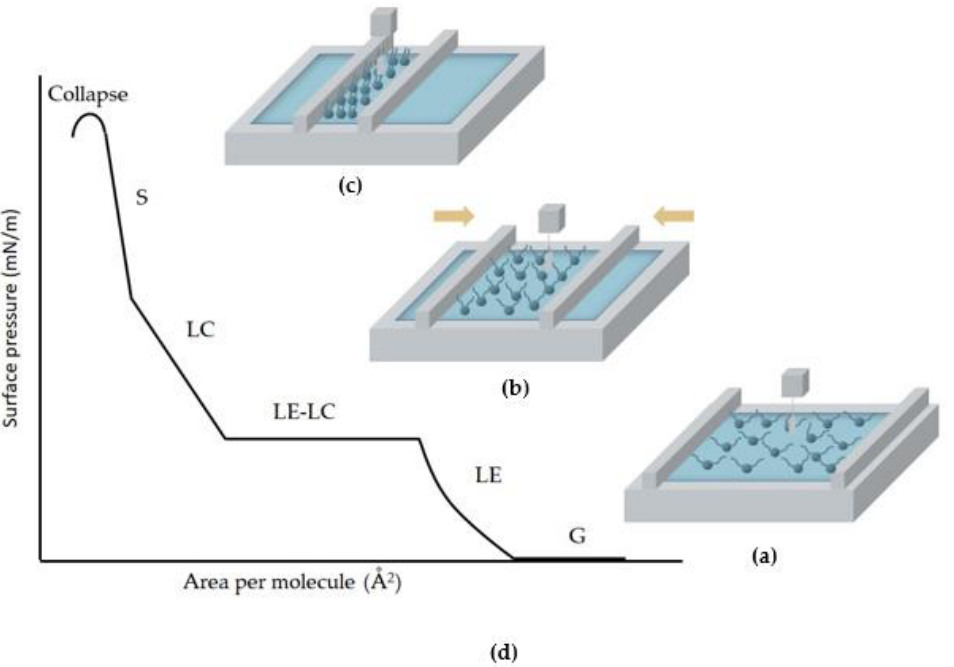
Figure 2. A schematic representation of the Langmuir monolayer formation process. ( a ) The lipid molecules are dissolved in an organic solvent and dispersed on the aqueous surface. The hydrophobic tails remain in the air with large tilt angles facing away from normal to the interface. ( b ) The two mobile barriers start to compress at a constant rate, and the Wilhelmy plate monitors the pressure. ( c ) Finally, the monolayer is formed with the molecules being perfectly organized. ( d ) A schematic of the π -A isotherm of the phospholipids. G: gaseous phase; LE: liquid expanded; LC: liquid condensed; and S: solid. During the compression process, the monolayer undergoes several phase transitions, from gaseous, to liquid, to solid states, and finally is perfectly self-oriented at the interface. Different phases are attributed to different degrees of freedom at various molecular organizations. Initially, the monolayer is in the gaseous phase with few interactions between the molecules. As the monolayer is compressed, the transition from the gaseous to liquid-expanded state occurs. The monolayer starts to be coherent, but the tail groups of the phospholipids are randomly oriented. As the area per molecule is further reduced, there are condensed lipid domains present in the expanded phase. Under further compression, the condensed phase is formed, where the monolayer exhibits a well-defined in-plane structure with a strong lateral cohesion. If the compression continues to be applied after the molecules are perfectly oriented, a collapse occurs due to mechanical instability [29].